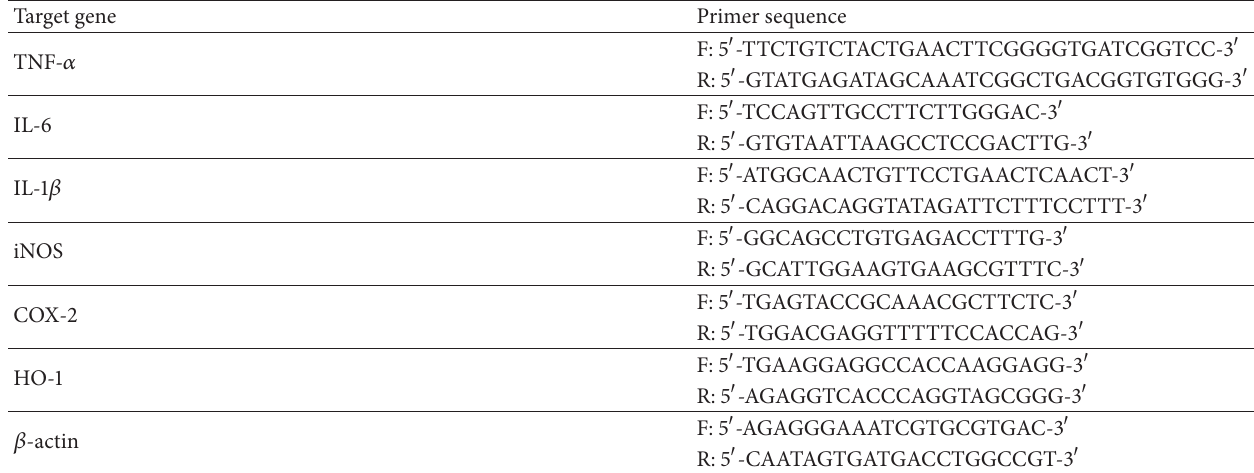
Table 1: Primers used for real-time